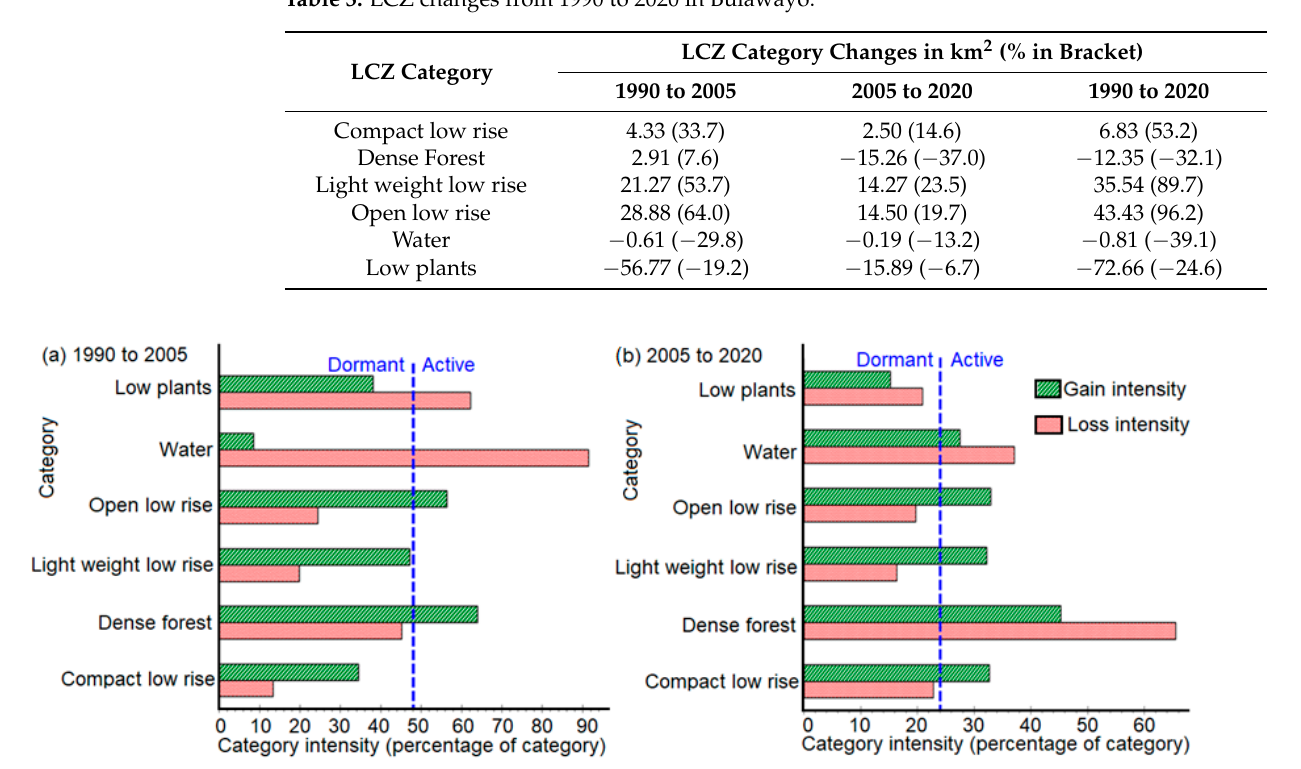
Figure 4. Category level intensity analysis for 1990 to 2005 ( a ) and 2005 to 2020 ( b ).